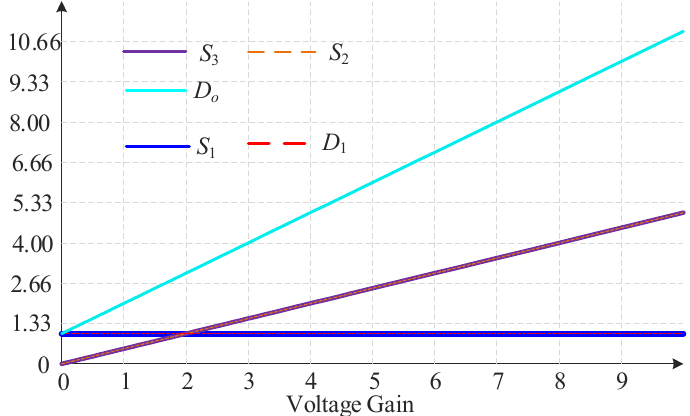
Figure 7. Circuit component voltage stress normalized to input voltage vs. converter voltage gain.